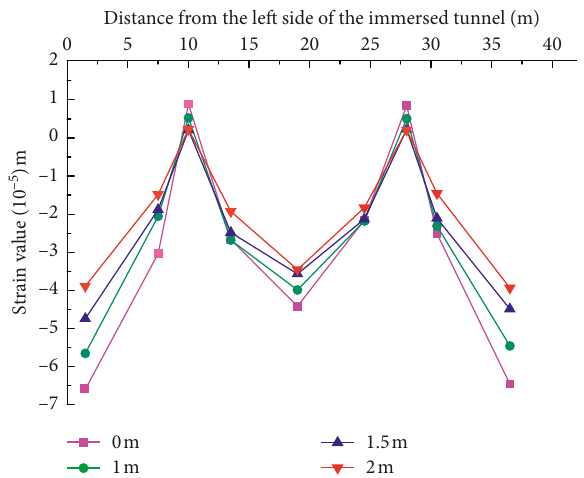
Figure 10: Strain distribution curve of the immersed tunnel bottom plate. Table 3: Settlement under different working conditions. Thickness of Recompression Settlement within cushion (m) displacement (cm) three years (cm)